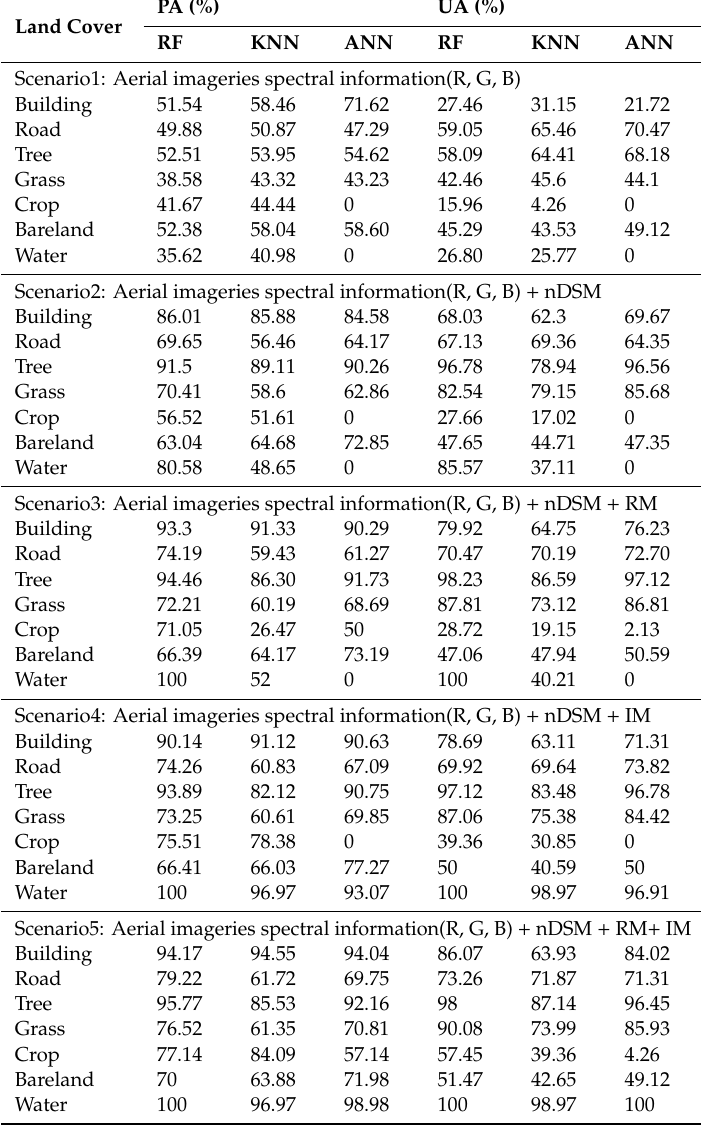
Table 3. Class level classification accuracies of three classifiers for each land covers. UA: user’s accuracy; PA: producer’s accuracy; nDSM: normalized digital surface model; RM: surface roughness model; IM: intensity